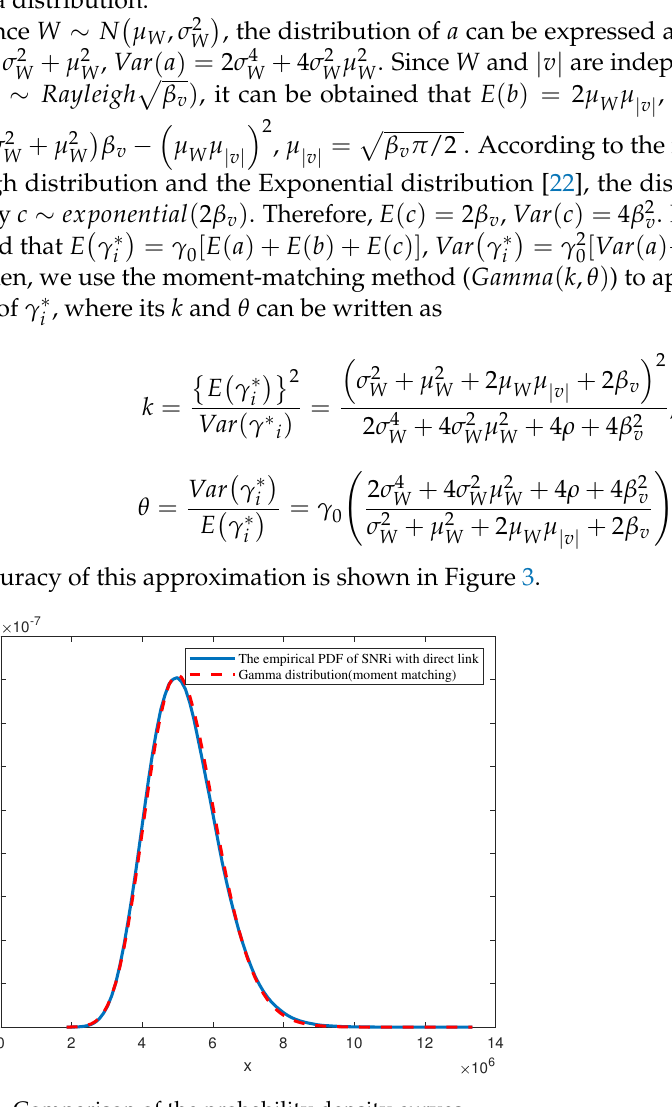
Figure 3. Comparison of the probability density